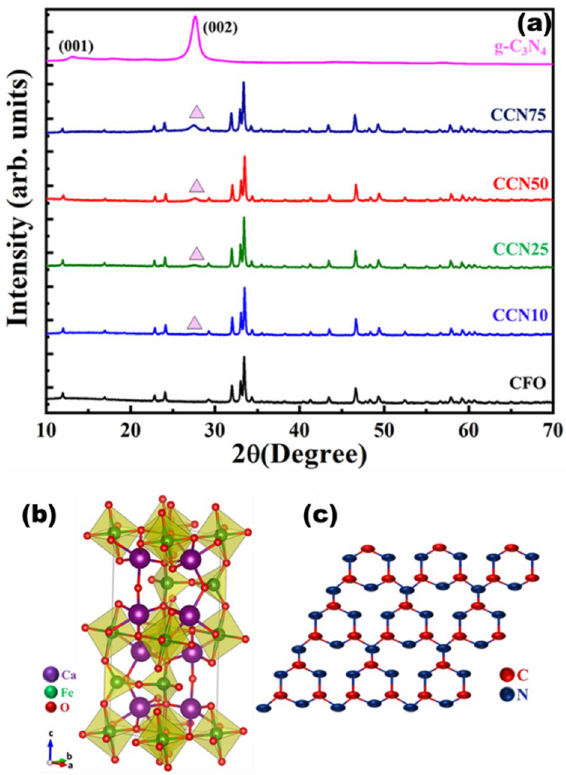
Figure 1. ( a ) XRD pattern of the CFO, g-C 3 N 4 , CCN10, CCN25, CCN50 and CCN75. ( b and c ) Structures of brownmillerite Ca 2 Fe 2 O 5 and layered g-C 3 N 4